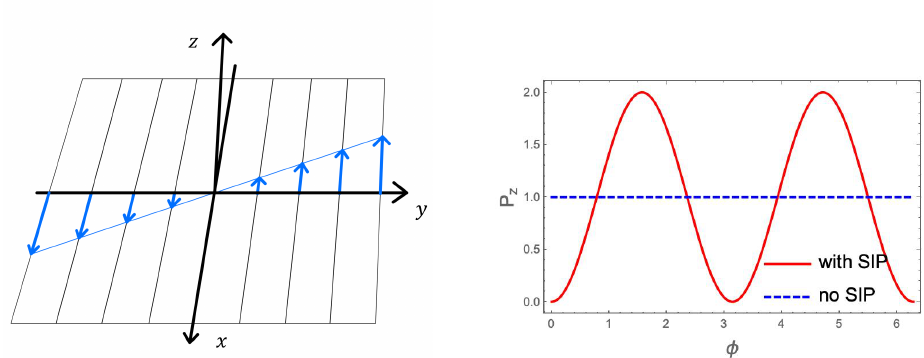
Figure 2 . An illustration of spin polarization density in phase space induced by a shear-flow profile. Left: we consider and plot a typical shear flow profile ∂ = − α , where α is a constant. The y u x corresponding vorticity and shear strength are σ x = σ y = α, ω z = α . According to eq. (5.4), the spin y x polarization vector projected to z -direction is given by: P z ∝ A z ∝ α (cid:0) 1 − sin 2 θ cos(2 φ ) (cid:1) . In the expression of P z , the first term is due to vorticity-induced polarization (see the first term of eq. (5.4)) and the second one is from “shear-induced polarization” (SIP), see the second line of eq. (5.4) or eq. (6.1) and the text. Right: the resulting (scaled) P vs φ at θ = 0 . We consider massless fermions z for illustrative purpose and parametrize the direction of the single particle momentum in terms of polar and azimuthal angle ˆ p = (sin θ cos φ, θ sin φ, cos θ )